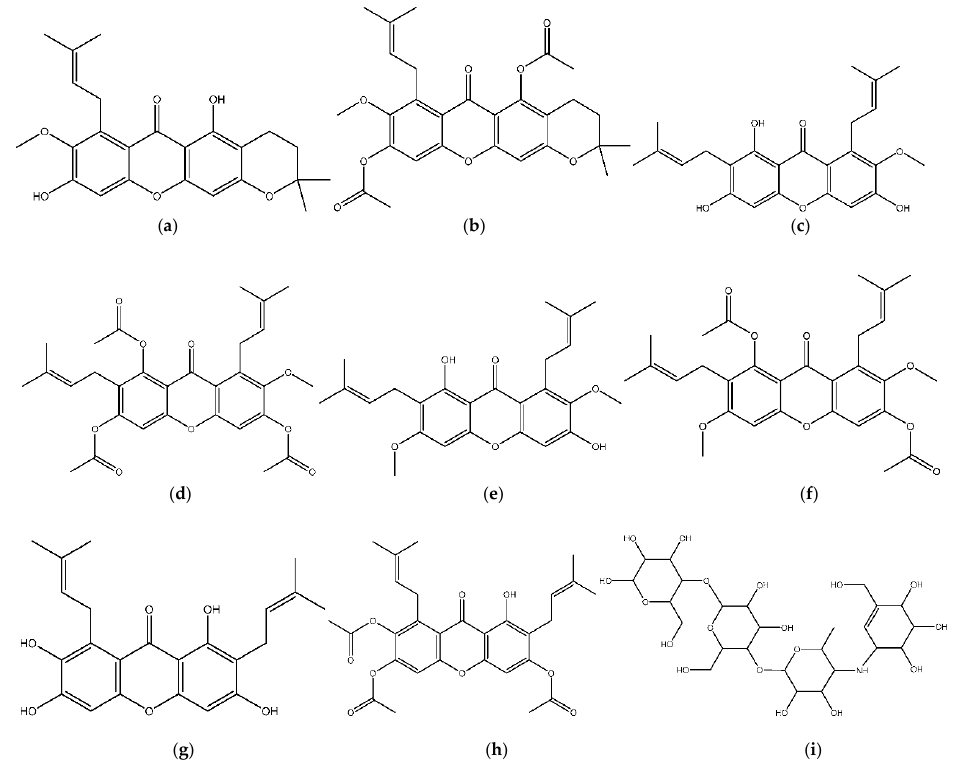
Figure 1. The structure of the ligand formed starts from ( a ) 3-isomangostin, ( b ) 1,6-dimethyl-ester- 3-isomangostin, ( c ) α -mangostin, ( d ) 1,3,6-trimethyl-ester- α -mangostin, ( e ) β -mangostin, ( f ) 1,6-di- methyl-ester- β -mangostin, ( g ) γ -mangostin, ( h ) 3,6,7-trimethyl-ester- γ -mangostin, and ( i ) acarbose.